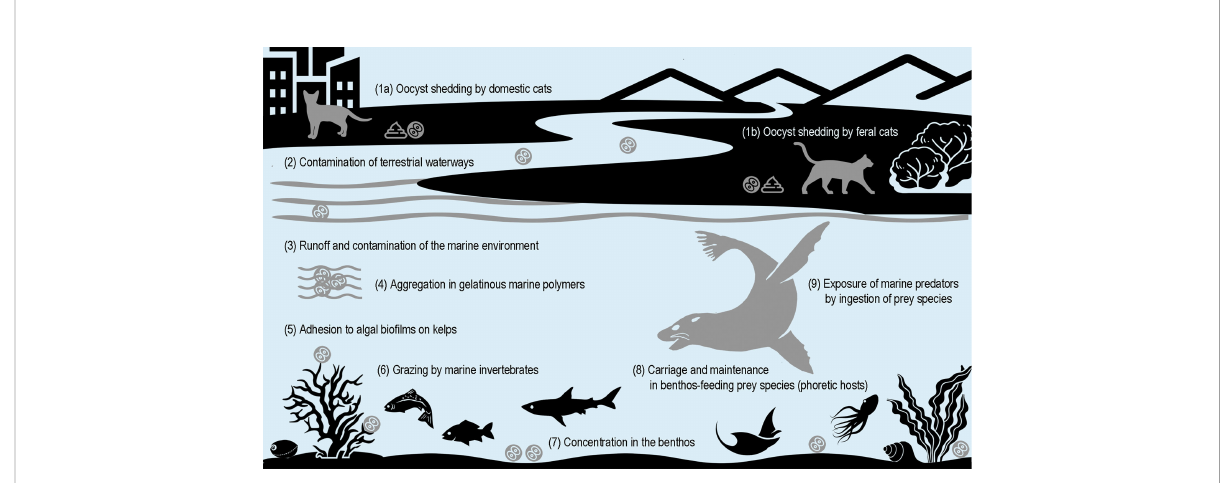
FIGURE 1 Proposed pathways for exposure of marine mammals to Toxoplasma gondii oocysts shed by terrestrial-bound de fi nitive felid